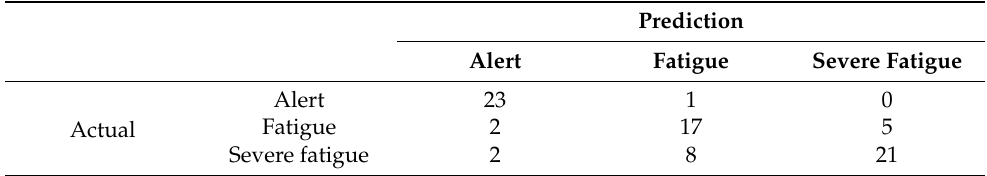
Table 8. Confusion matrix based on the BP neural network (the test results when the test accuracy reaches the